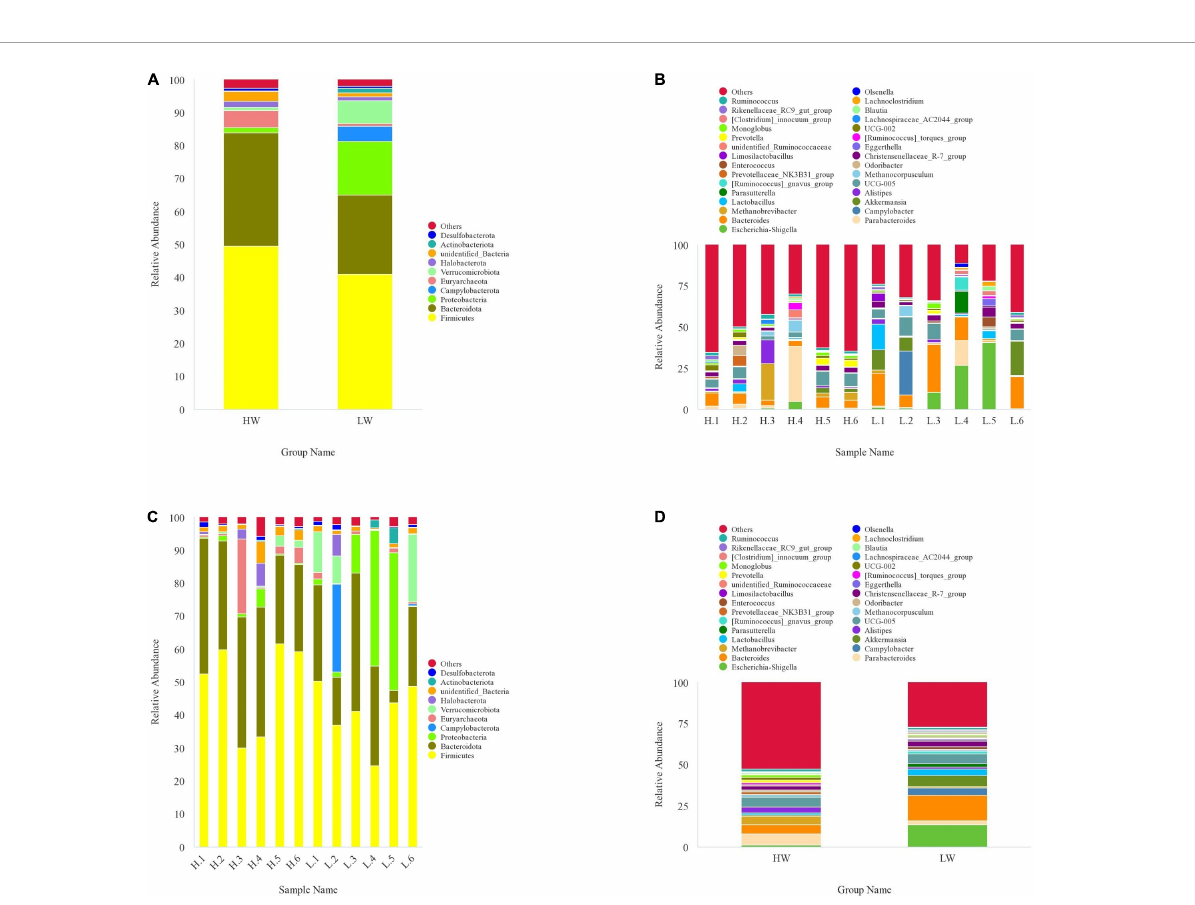
FIGURE3 The taxonomic distribution between HW group and LW group samples (each color represents the relative abundance of a taxonomic bacterium). (A) at phylum level (top 10). (B) at genus level (top 30). (C) Between-group at phylum level (top 10). (D) Between-group at genus level (top